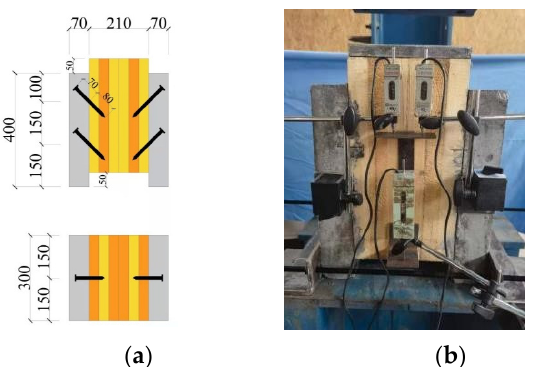
Figure 3. ( a ) Schematics of push-out tests (units: mm) and ( b ) the photograph of the push-out test system (Reproduced with permission from Ref. [8]. Copyright 2022 Elsevier.).